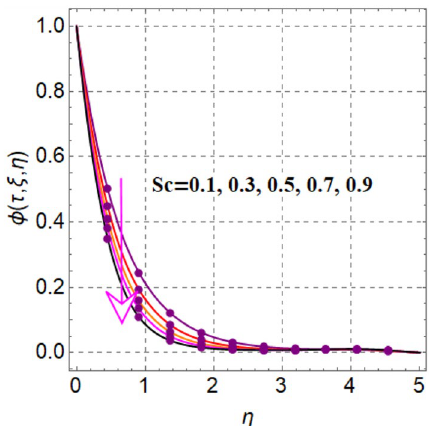
Figure 11. φ(τ , ξ , η) via Sc .